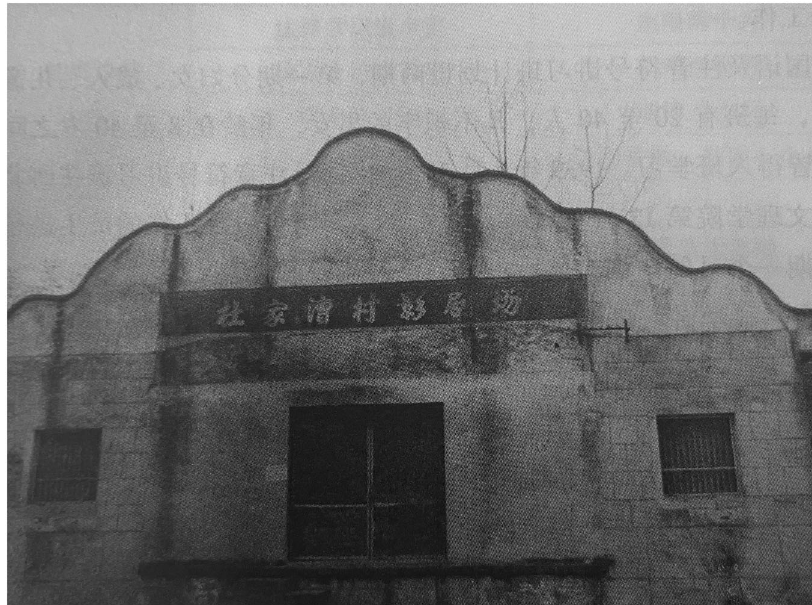
Fig. 5 The place where the villagers of Dujiacao watched fi lms. Dujiacao Village is a rural social education area of Northwest United